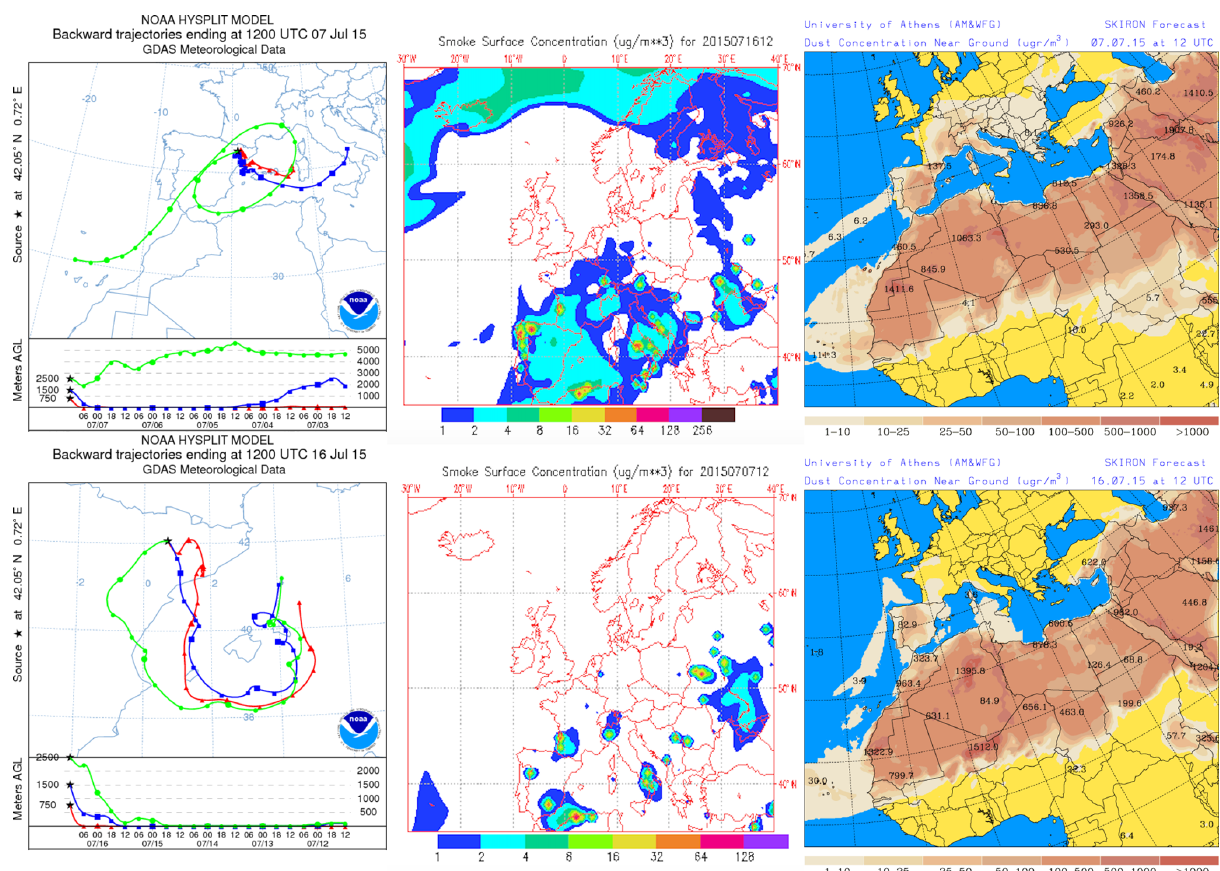
Figure 2. Upper panel shows the back trajectories at the MSA station, the dust concentration (µgm − 3 ) near the ground as simulated by the SKIRON forecast simulations (University of Athens) and the smoke surface concentration (µgm − 3 ) forecasted by the NAAPS Prediction System for 12:00UTC of the 7 July 2015 (flights P1 and P2). The lower panels shows the same information for 12:00UTC on 16 July 2015 (flights P6 and P7), although it should be noted that there is a smaller scale on the back-trajectory map, with a higher zoom in the study area. GDAS: Global Data Assimilation